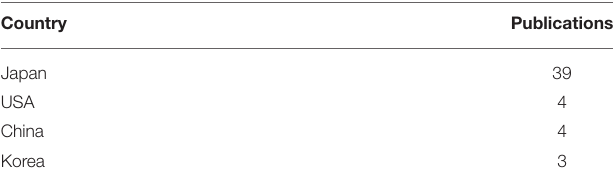
TABLE 4 | Countries of the 50 top cited articles on